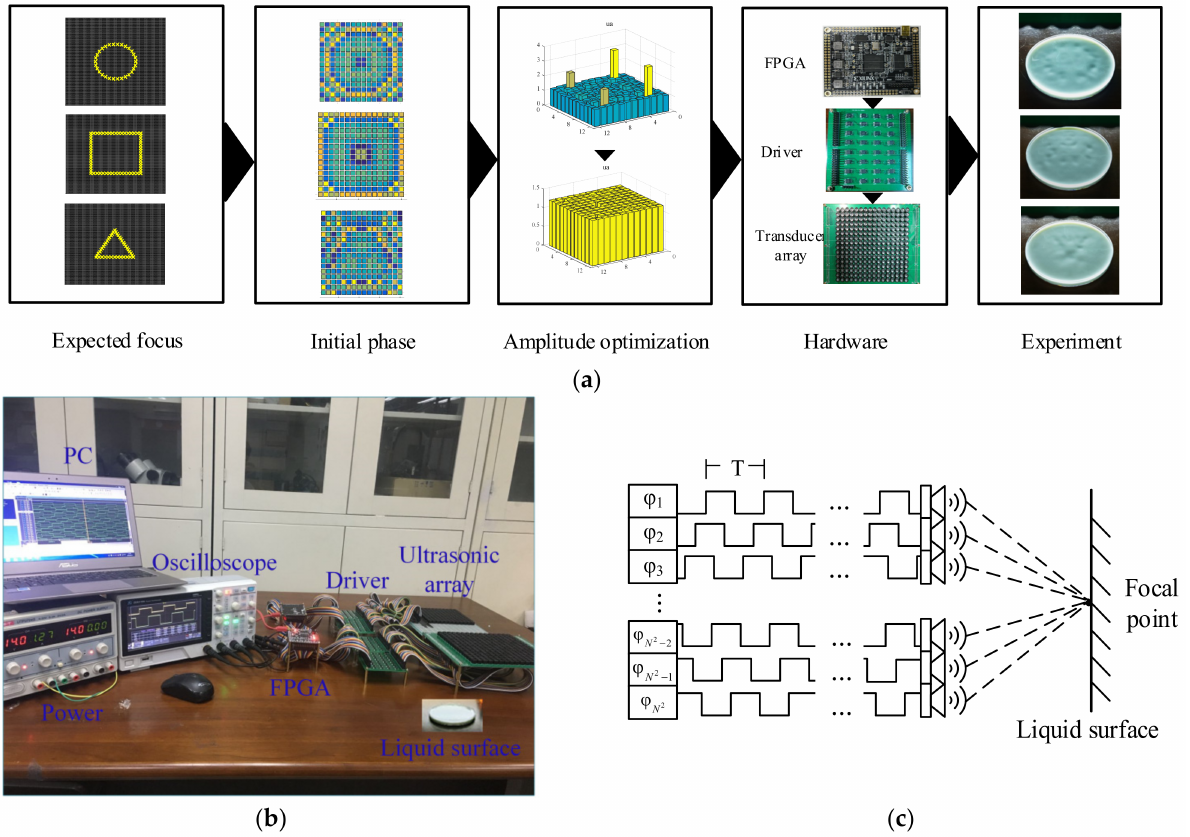
Figure 9. Experimental platform. ( a ) is the implementation procedure for the ultrasound haptic feedback from simulations in experiments. ( b ) shows the hardware architecture of the ultrasound control system. ( c ) shows that the transducer arrays are triggered in a certain phase